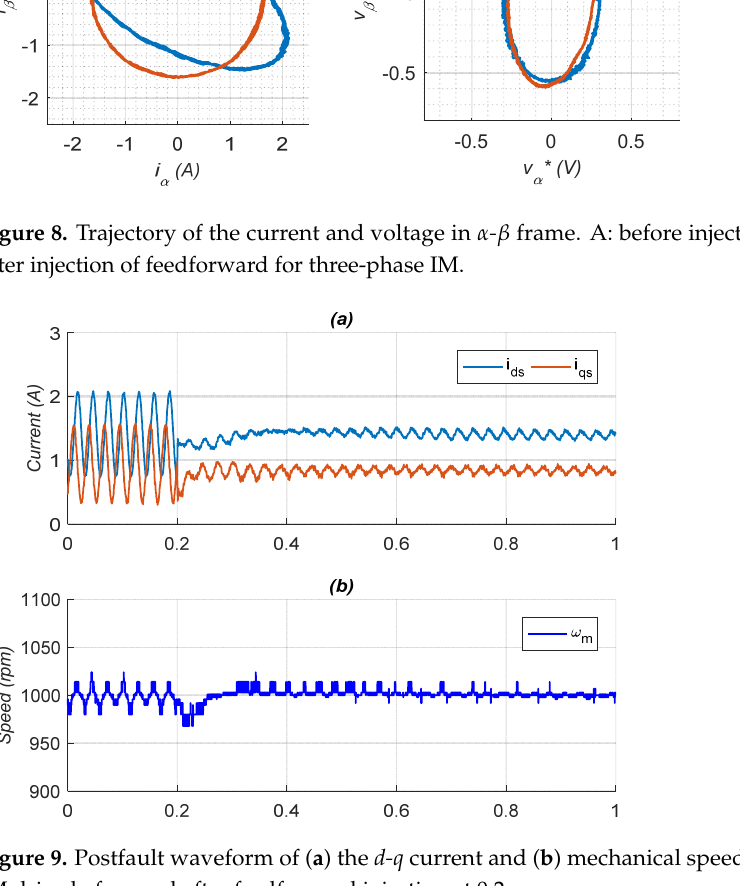
Figure 10. Postfault experimental result for the symmetrical six-phase IM drive with feedforward injected at 0.2 s: ( a ) α - β and x voltage, ( b ) feedforward voltage, ( c ) phase current of set1, ( d ) phase current of set 2.